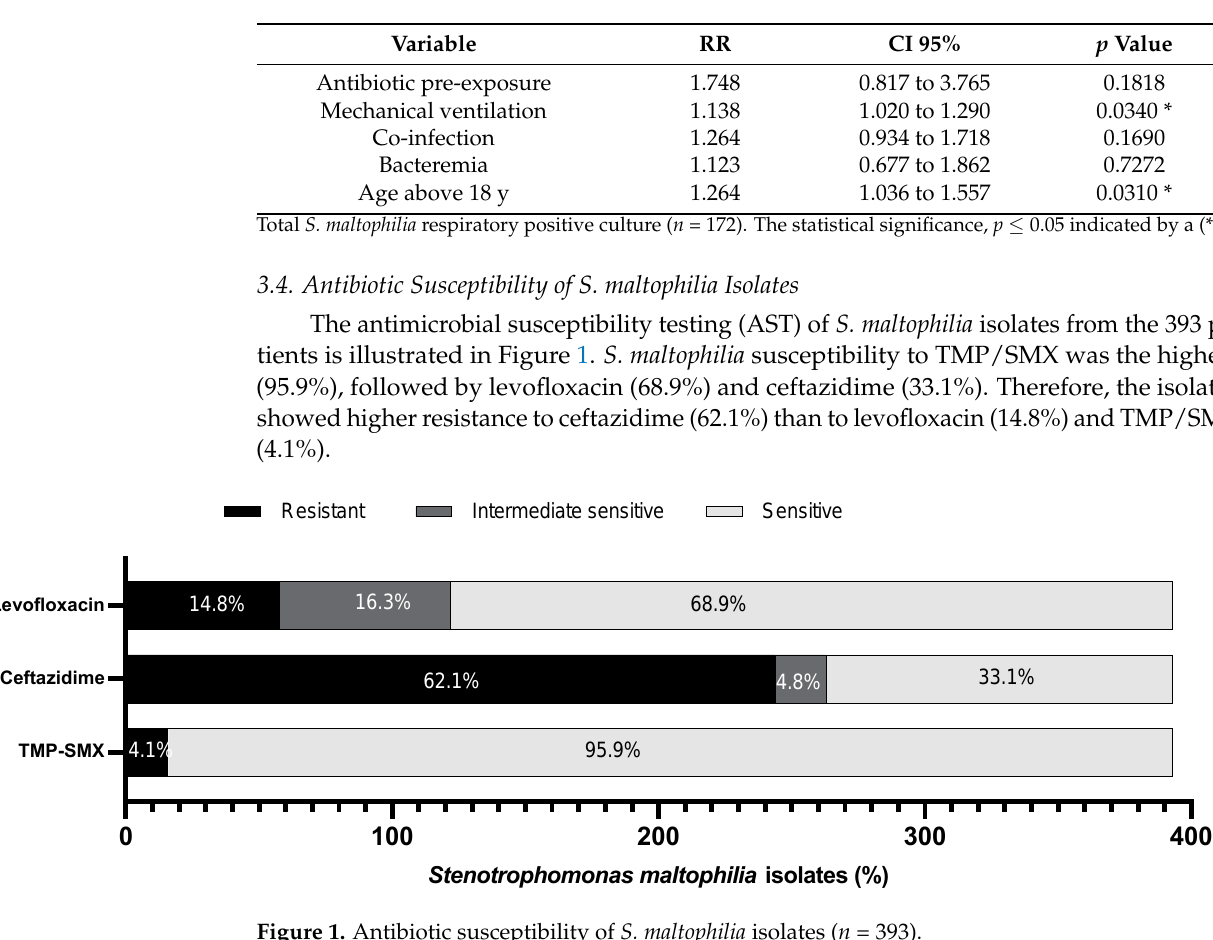
Figure 1. Antibiotic susceptibility of S. maltophilia isolates ( n = 393).